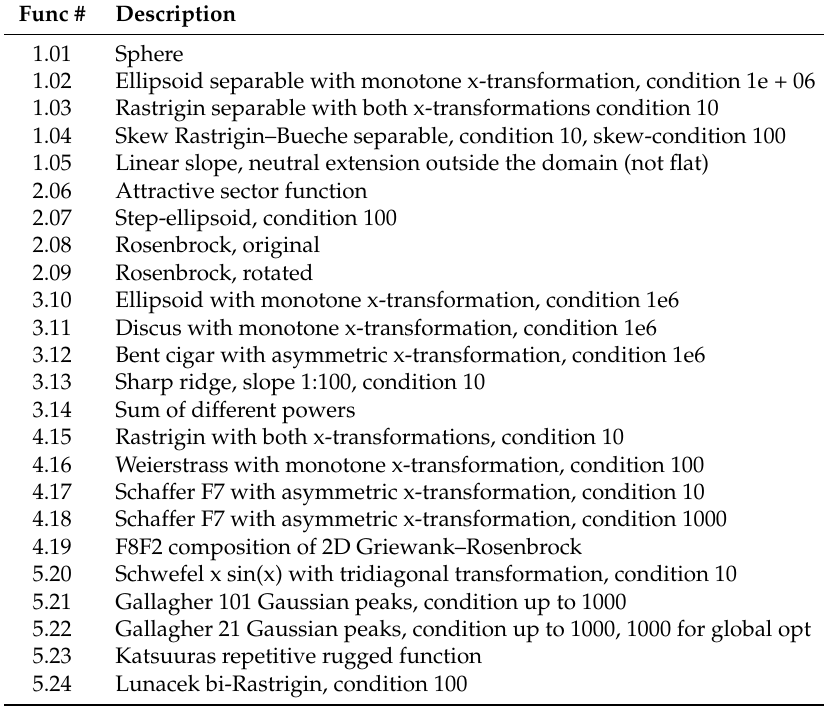
Table 1. Description of the functions used in the experimental